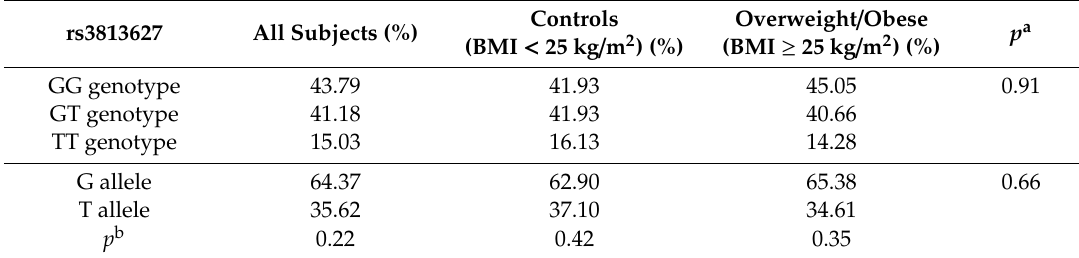
Table 2. Genotypic and allelic frequencies APOA2 rs3813627